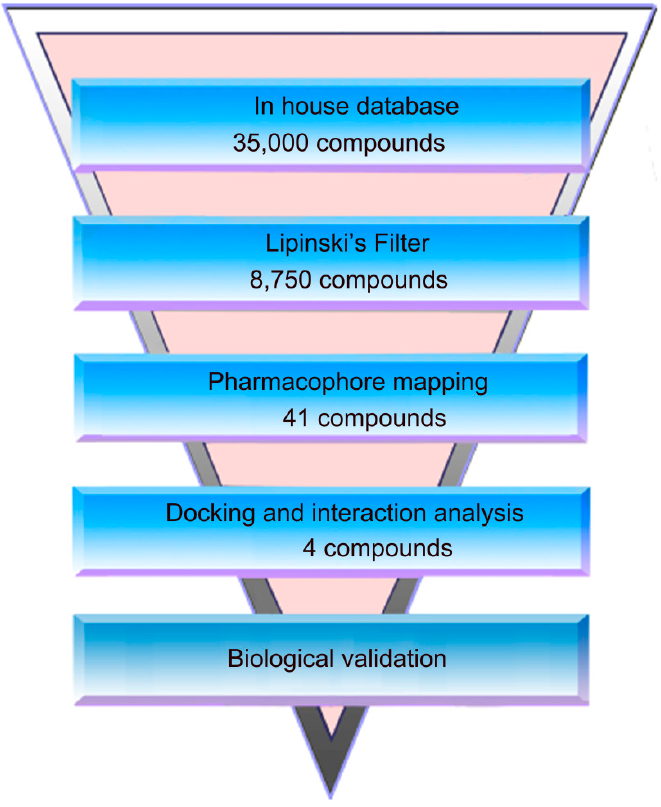
Figure 2. A workflow overview of pharmacophore modeling, selection of compound and biological testing.